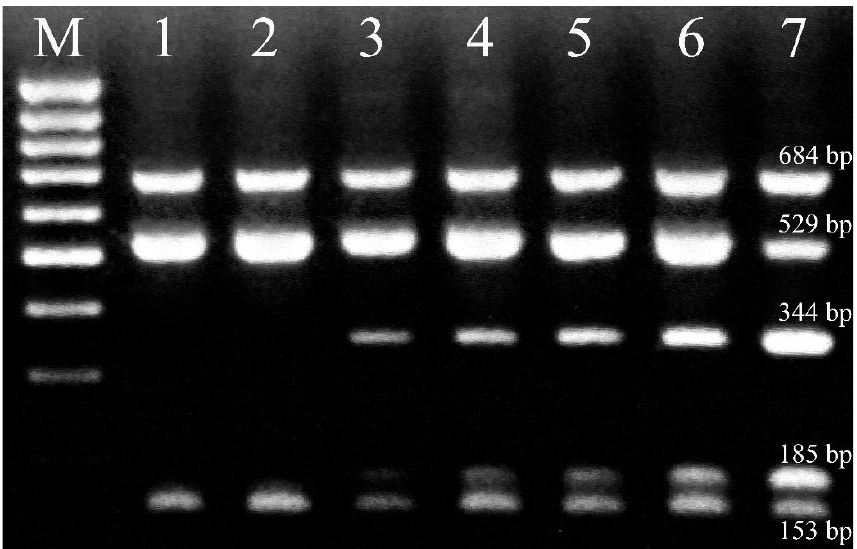
Figure 2. PCR-RFLP electrophoretic patterns of selected samples by using Msp I for restriction (1 – 7). M, DNA 100 bp size standard. Table 2 . Replicate PCR-RFLP analyses (by using Msp I) on selected samples. The values are ex- pressed as % of electrophoretic band intensity calculated on the sum of the three bands involved, the average of four replicates. Values in brackets are standard deviations of the measurements.